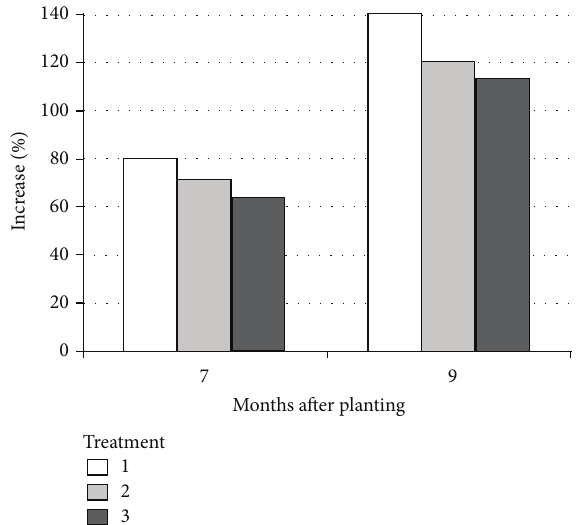
Figure 4: Increases of basal diameters for the argan tree seedlings. Treatment 1: control. Treatment 2: seedlings with 120cm shelters. Treatment 3: seedlings with 150cm